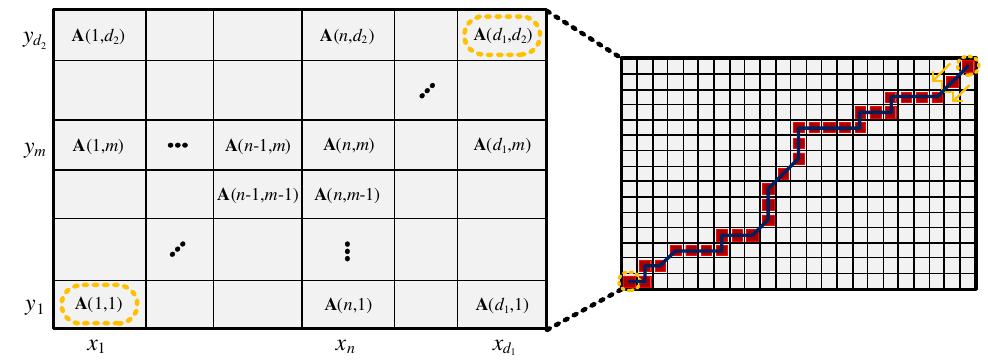
Figure 4. Accumulated cost matrix.